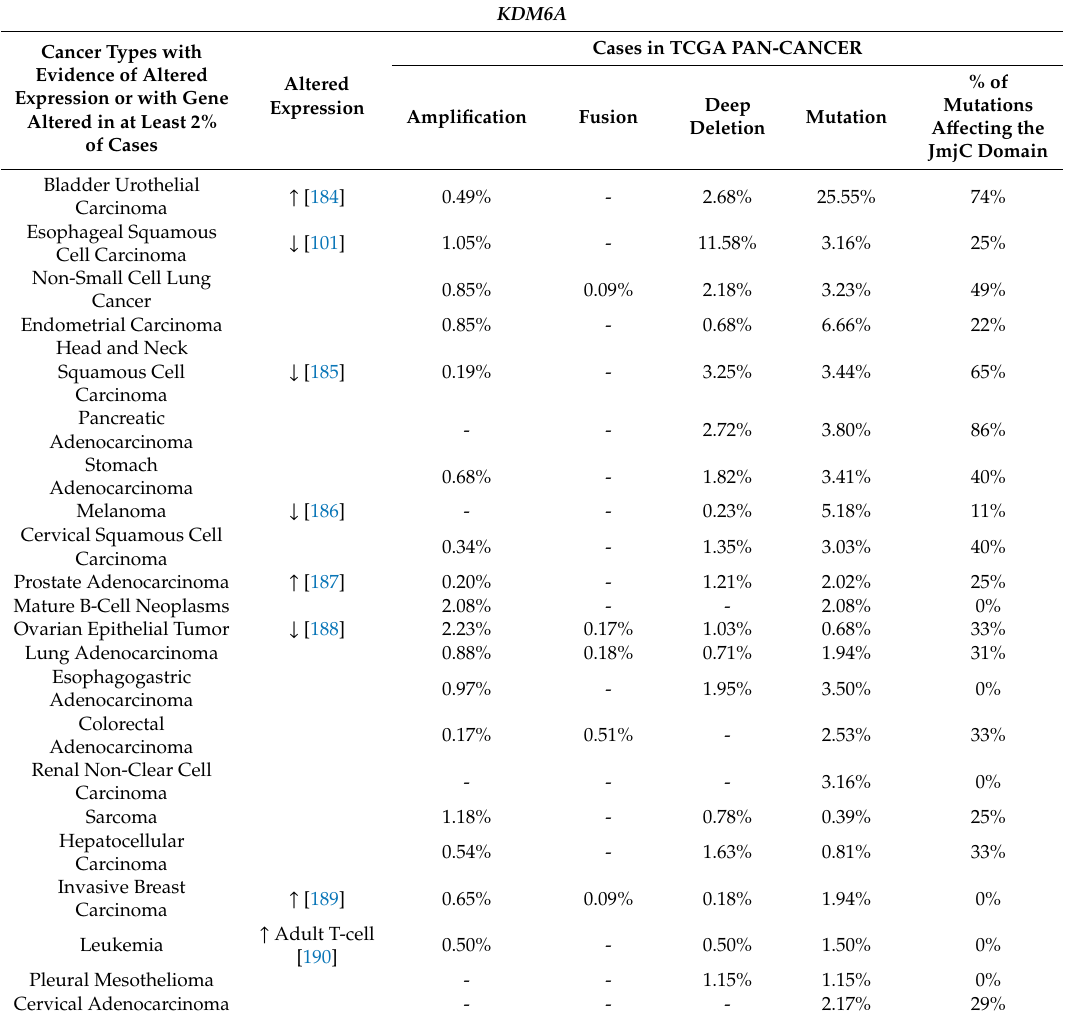
Table 2. KDM6A alterations by cancer type. Data on expression status was collected from studies deposited in Oncomine (http: // www.oncomine.org / ) or in the scientific literature. Data on mutation, gene amplification, and deletion were collected from the TCGA PanCancer dataset using cBioPortal [79,80]. Cancer types with alteration at KDM6A in at least 2% of cases are shown. All mutations within the JmjC domain or truncating mutations prior to the JmjC domain were considered to compromise enzymatic